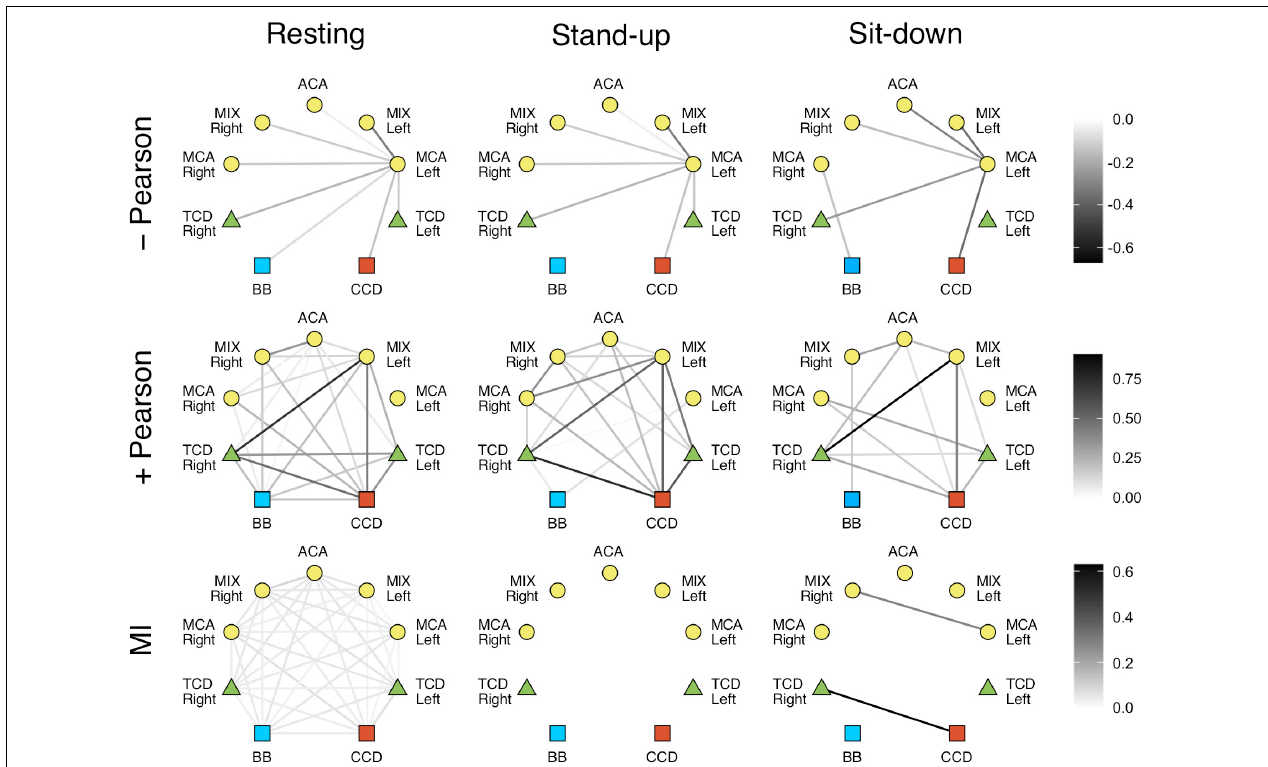
FIGURE 5 | Cardiorespiratory-cerebrovascular networks reconstructed for the high-frequency range (0.4–1.5 Hz) after surrogate thresholding. Strength of connection was assessed using Pearson correlation analysis (upper panels: negative correlations, middle panels: positive correlations) and mutual information analysis (MI, lower panels) and is coded in grayscale. CCD, Cardiac cycle duration; BB, Breath-to-breath interval; TCD, transcranial Doppler (denoting the BFV signal recorded from MCA); ACA, anterior cerebral artery; MCA, middle cerebral artery; MIX, NIRS channels sampling regions supplied by ACA and